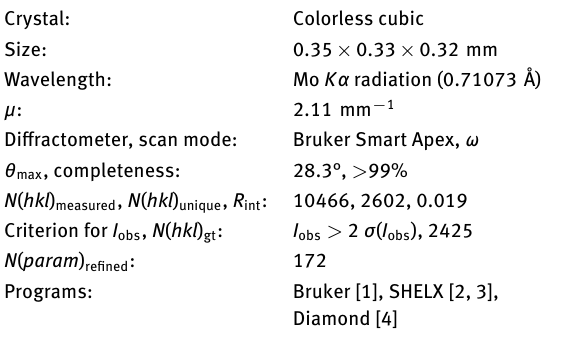
Apartofthemolecularstructureisshowninthefigure.Table1 contains crystallographic data and Table 2 contains the list of the atoms including atomic coordinates and displacement